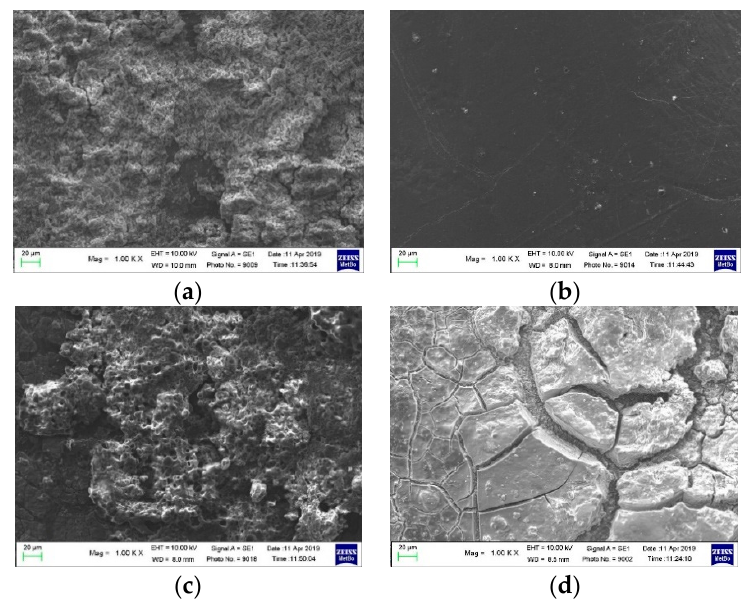
Figure 8. SEM images of ( a ) pristine lithium, ( b ) lithium anode after cycling, separator side toward Li of ( c ) CN01 and ( d ) CN01p cells.